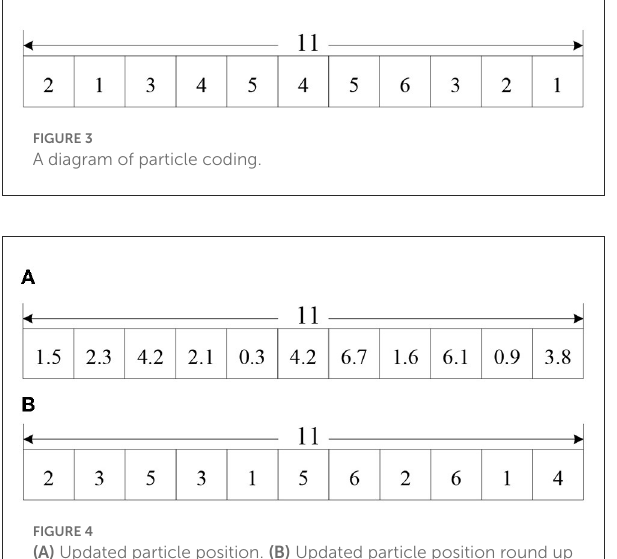
FIGURE4 (A) Updated particle position. (B) Updated particle position round up to integers.